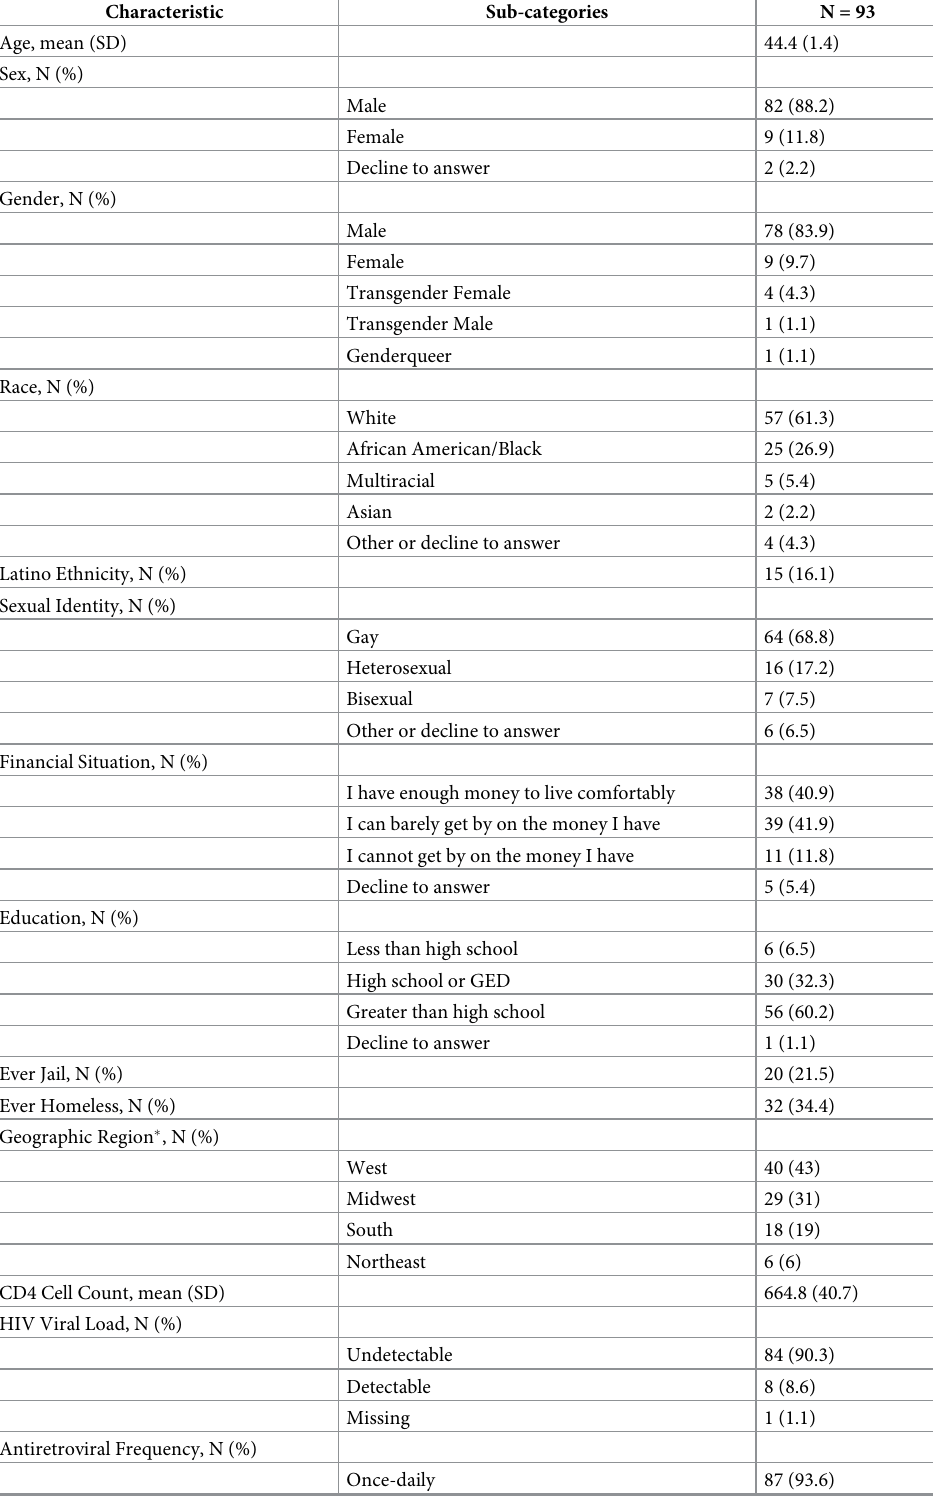
Table 1. Participant